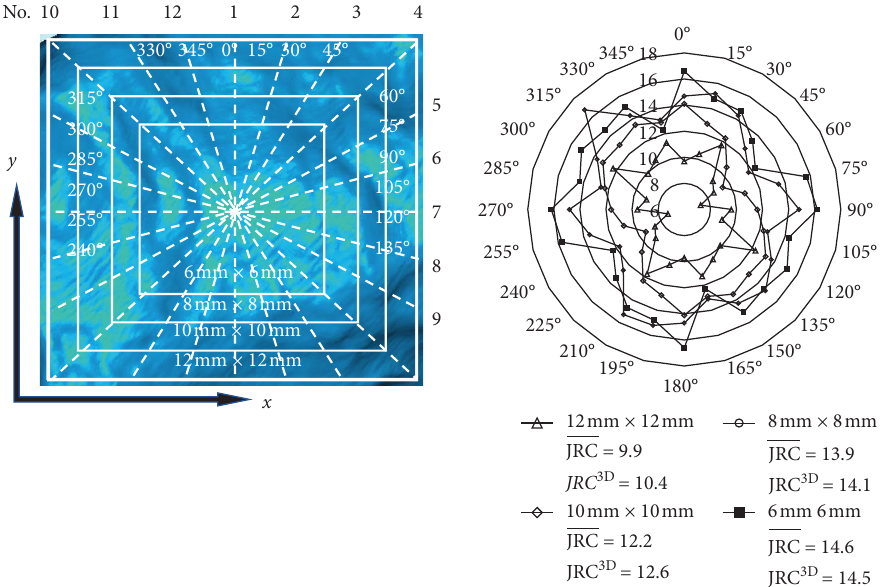
Figure 6: The size effect of the roughness of the aggregate